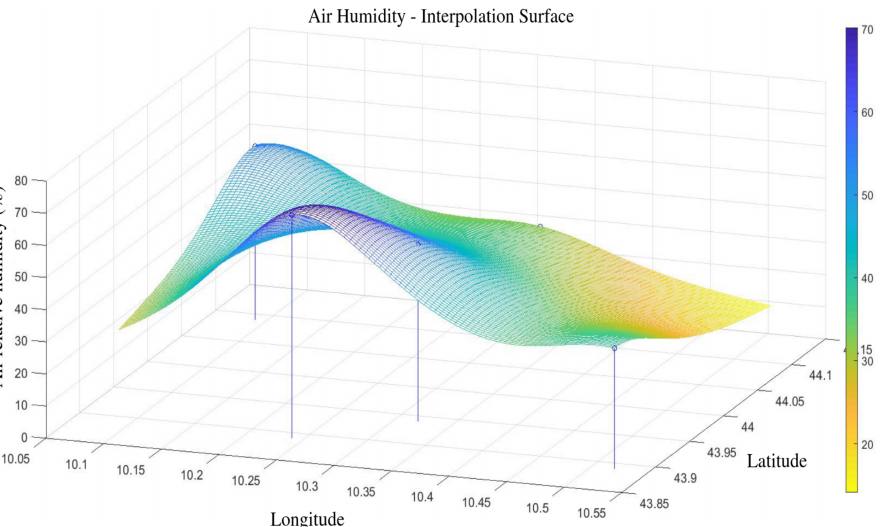
Figure 6. Kriging interpolation of air humidity over the area of interest in an r day. Vertical lines localize the weather